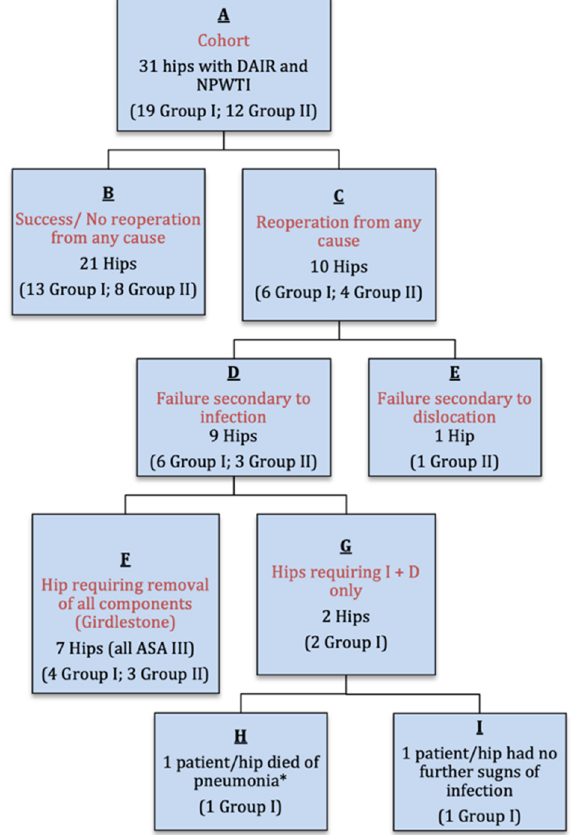
Figure 1. Flow chart (I + D = Irrigation and Debridement; * This patient in Group 1 was ASA Grade III and died 24 days post DAIR with MRSA and pneumonia and is considered a treatment failure).